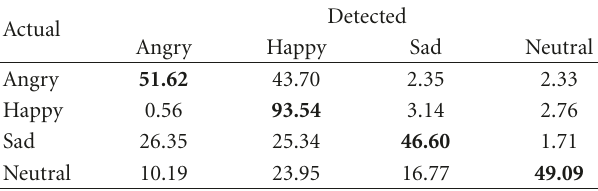
Table 4: Four emotions recognition rate (%) for a balanced speaker and text independent test-utterance based: 100 utterances per emotion, random sequence of speakers after